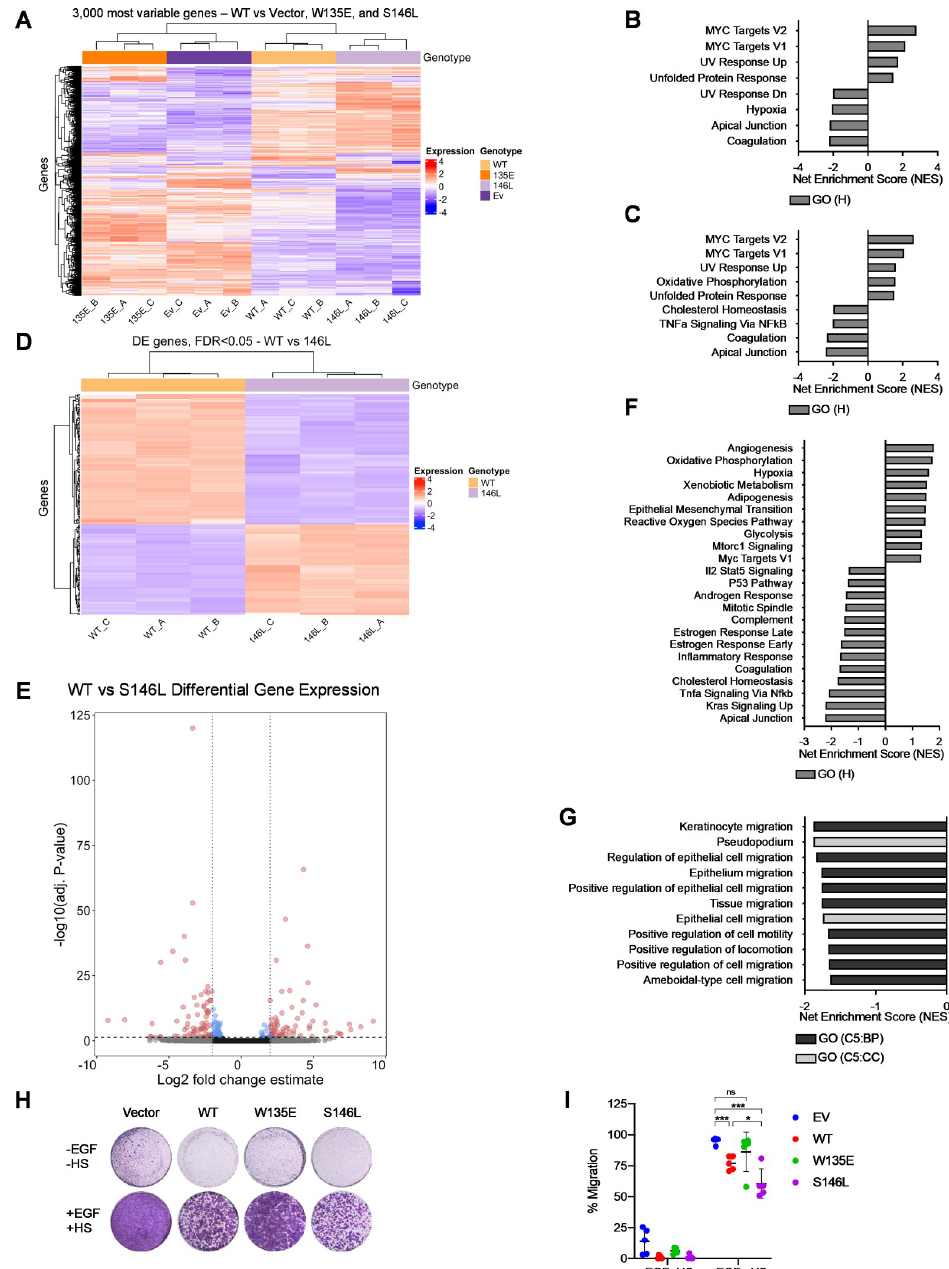
Fig 3. MYC S146L drives gene expression distinct from WT MYC. (A) Unsupervised hierarchical clustering of 3000 most variable genes between vector-transduced MCF10A cells (Ev), V5-tagged WT MYC, W135E, and S146L as determined by RNA-seq (n = three biological replicates). (B) Gene-set enrichment analysis (GSEA) for Hallmark gene sets differentially activated in cells expressing WT MYC compared to vector. Plot represents upregulated gene sets and four most downregulated gene sets. (P values < 0.05) except for REACTIVE OXYGEN SPECIES, MTORC1 SIGNALING, MYC TARGETS V1, and IL2 STAT5 SIGNALING (P values 0.05–0.1). (C) Gene-set enrichment analysis (GSEA) for Hallmark gene sets differentially activated in cells expressing MYC S146L compared to vector. Plot represents upregulated gene sets and four most downregulated gene sets. FDR < 0.05. (D) Unsupervised hierarchical clustering of genes with a fold change > 2 between WT MYC and MYC S146L. DE = differential expression. FDR = false discovery rate. (E) Volcano plot representing differentially expressed genes between WT MYC and MYC S146L. The y-axis in the volcano plot represents adjusted P-values that control for the FDR using the Benjamini & Hochberg method. (F) GSEA of Hallmark gene sets between WT MYC and MYC S146L. Plot represents selected most